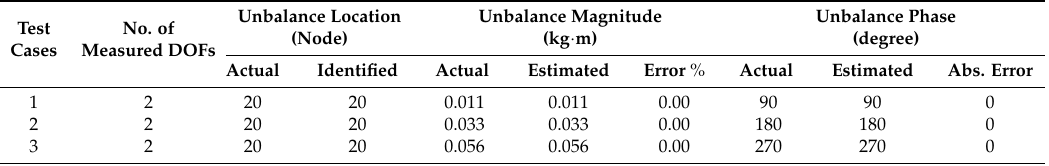
Table 7. Estimation results for different values of unbalance magnitudes and phases induced in the paper machine’s tube roll using the displacement minimization method.